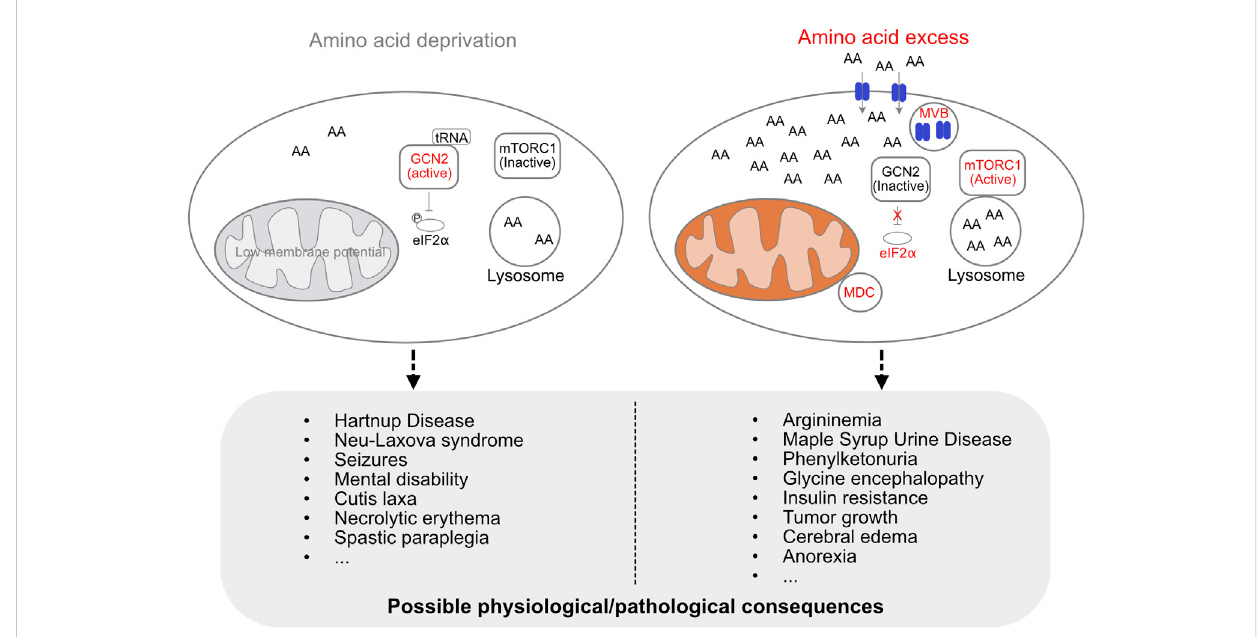
FIGURE 1 Cellularregulationofaminoacidlevelsandpossiblephysiological/pathologicalconsequencesofaminoacidde fi ciencyorexcess.Thelackofamino acids is sensed by GCN2, which is activated upon binding to an uncharged tRNA. Activated GCN2 phosphorylates eIF2 α to prevent translation initiation. Amino acid de fi ciency decreases mitochondrial membrane potential (low membrane potential indicated in grey, otherwise shown in orange). Excess aminoacidsareimportedandsequesteredbythelysosome,activatemTORC1,andinducetheformationofMDCandMVB.Aminoacidde fi ciencyor amino acid overload in the cell can lead to a variety of